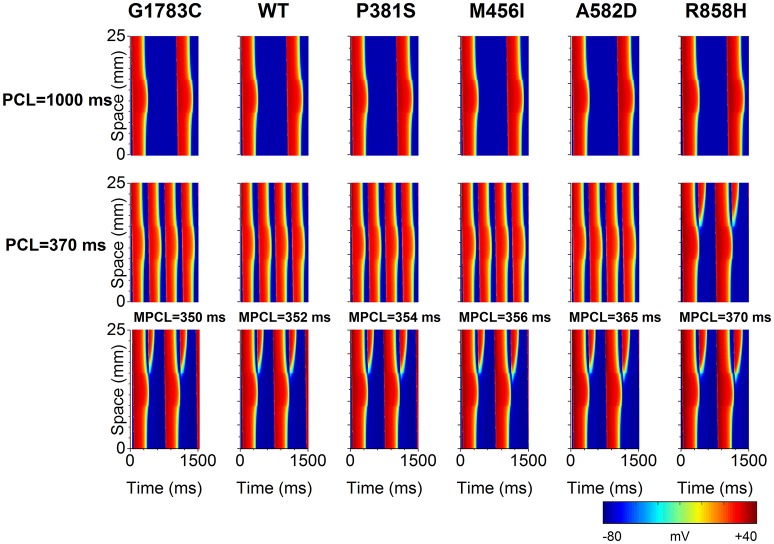
Space-time plots of action potential propagation in a one-dimensional (1D) transmural ventricular cable at different pacing cycle lengths (PCL). At PCL of 1,000 ms, no conduction block is shown. At PCL of 370 ms, unidirectional conduction block occurs under the R858H condition. When the PCL is decreased, unidirectional conduction block can occur under other conditions. The maximum PCL (MPCL) that produced unidirectional conduction block for G1783C, wild-type (WT), P381S, M456I, A582D, and H858R is 350, 352, 354, 356, 365, and 370 ms, respectively.